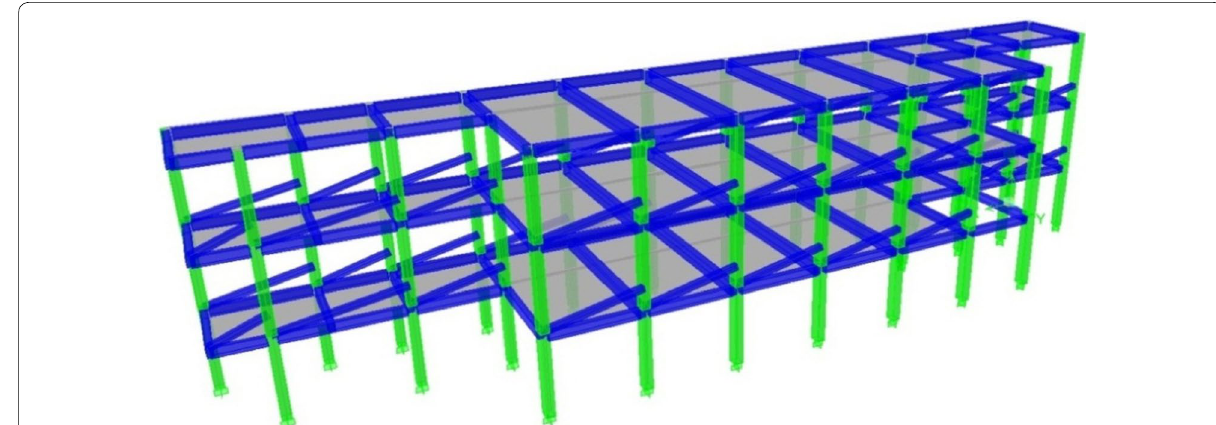
Fig. 20 The finite element model of the selected RC school building.